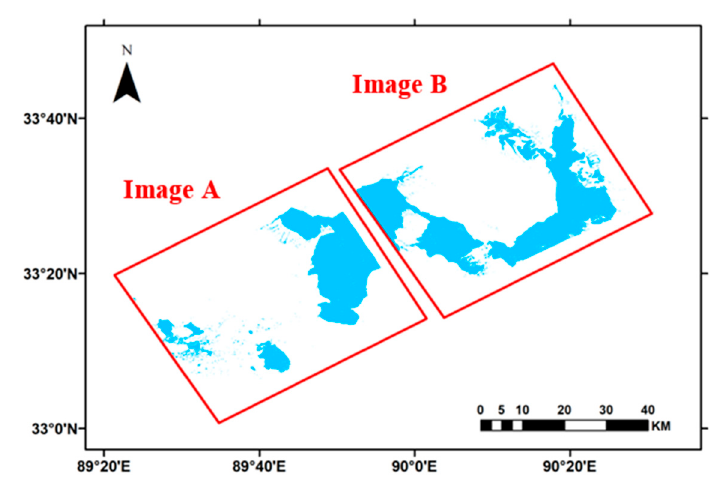
Figure 4. Lake water detected by Tian Gong 2 InIRA images acquired on 23 September 2016 using a dynamic threshold algorithm (blue: water; white: land or no retrievals).